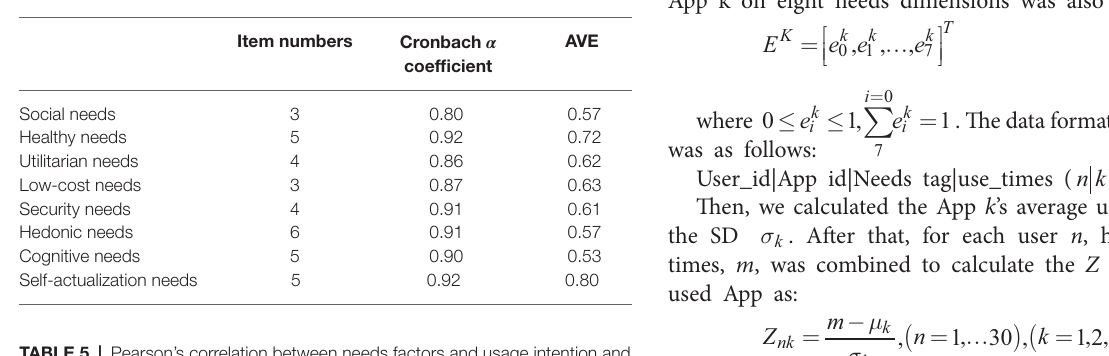
TABLE 4 | Cronbach α coefficient and average variance extracted (AVE) of